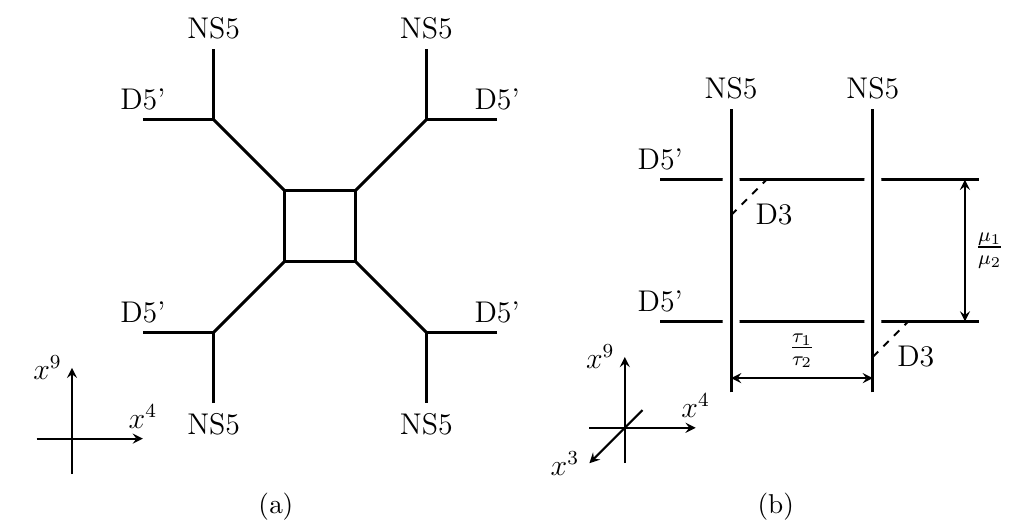
Figure 4 . a) The ( p; q ) (cid:12)ve-brane web formed by pairs of intersecting D5’ and NS5 branes in the 49 plane, corresponding to the 5 d N = 1 SU(2) gauge theory with four fundamental hypermultiplets. b) The Higgs branch of the 5 d theory corresponds to the con(cid:12)guration of (cid:12)ve-branes separated along the x 3 direction. Here we consider the case where two D3 branes (here depicted as dashed lines) are stretching between the